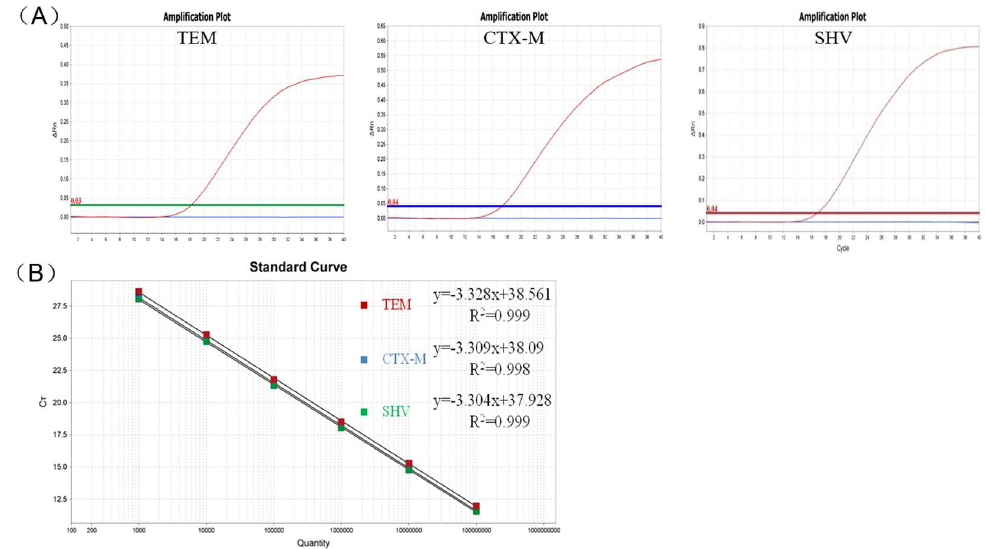
fluorescence signals, and no positive signals were observed with ATCC 29522 and nuclease- free H 2 O (Figure 4A).